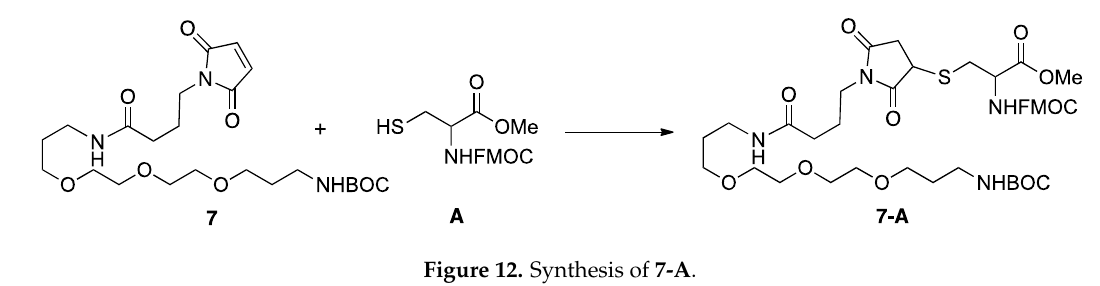
Figure 10. Synthesis of 7-A . Figure 12. Synthesis of 7-A .